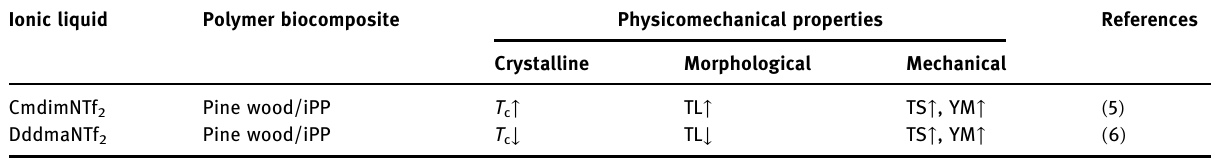
Table 6: Physicomechanical properties of polymer biocomposites pretreated with bistri fl imide - based ionic liquids Ionic liquid Polymer